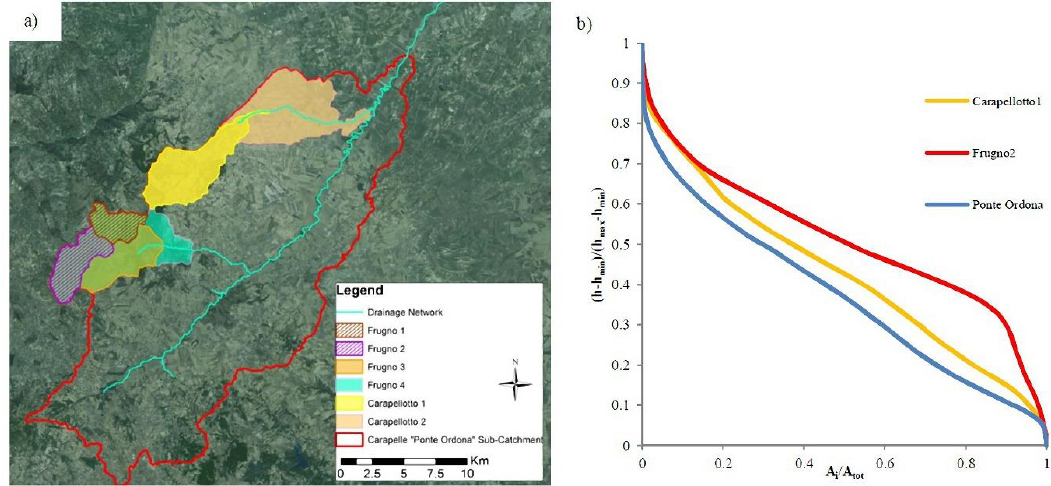
Figure A1. Sub-basins candidate to be gauged ( a ) and hypsometric curves with significant similarity ( b ).